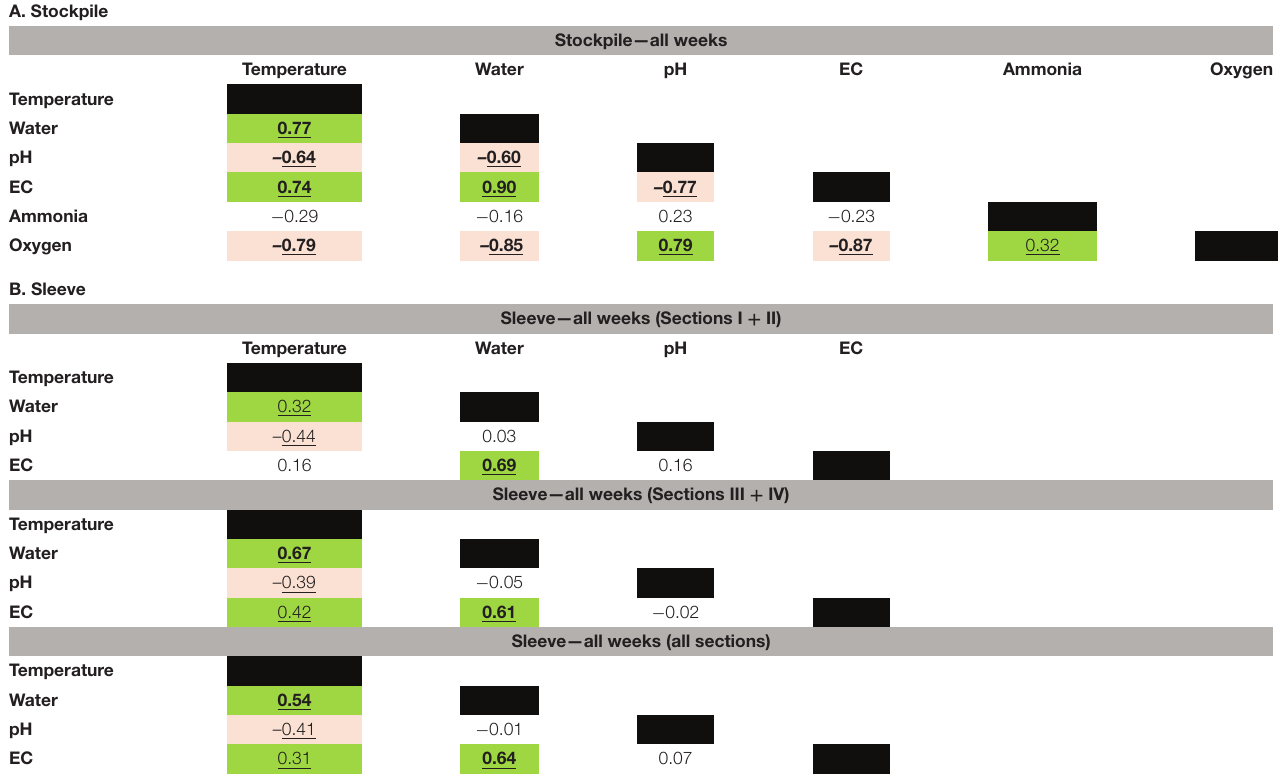
TABLE 2 | Pearson’s r linear correlation coefficients among the physicochemical properties measured in the stockpile and the sleeve during 2